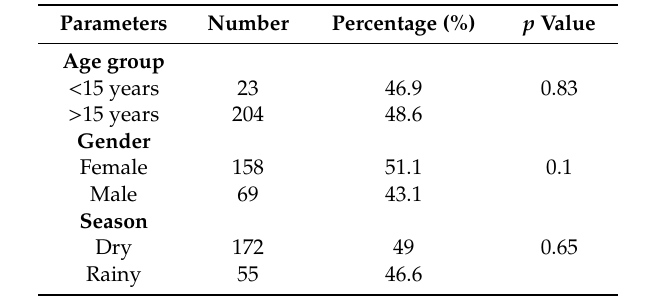
Table 4. Prevalence of onychomycosis according to the socio-demographic characteristics of the study population ( n =